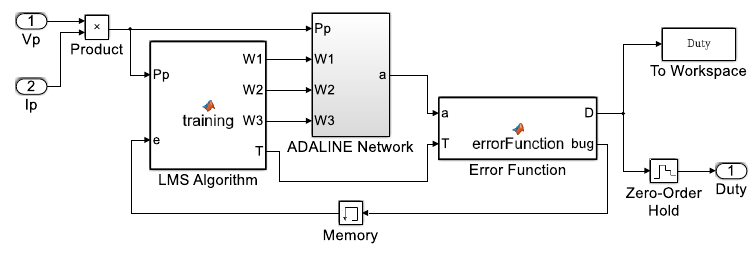
Figure 9. Block diagram of the ADALINE network with LMS algorithm.